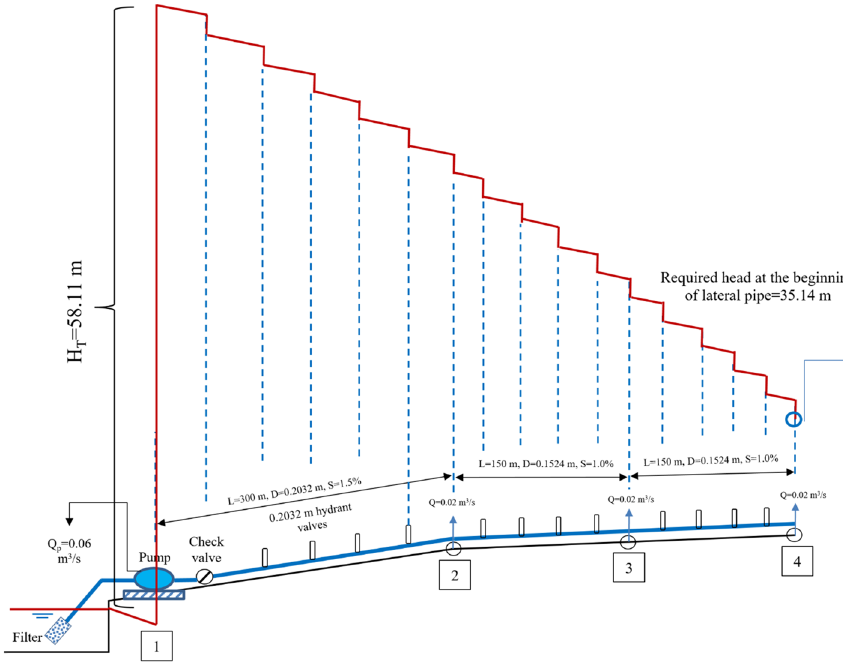
Fig. 10 Energy line of the system in schematic